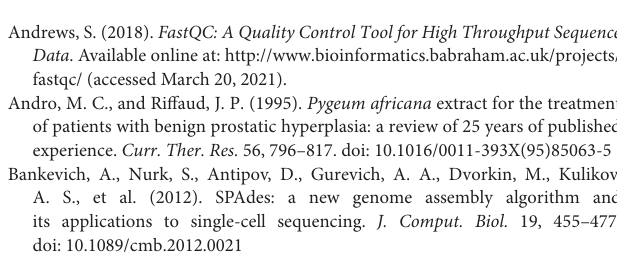
Supplementary Figure 1 | Structural variation between plastomes of Maddenia and outgroups revealed by Mauve. Supplementary Figure 2 | Comparison of the large-single-copy (LSC), inverted repeats (IRs), and small-single-copy (SSC) border regions of Maddenia plastomes. Supplementary Figure 3 | Microsatellites number of different base compositions and distribution of all repeated sequences. (A) Frequency of microsatellites by base composition; (B) Number of all repeats by location. CDS, coding sequences; IGS, intergenic spacers. Supplementary Figure 4 | Phylogenetic relationships of Maddenia inferred from Bayesian inference (BI) and maximum likelihood (ML) based on six datasets. (A) complete plastomes; (B) coding regions; (C) LSC region; (D) non-coding regions; (E) SSC region; (F) IR region. The support values above the branches show PP (posterior probability) / BS (bootstrap support), and asterisks indicate 1.00/100%. Dashes represent incongruences of BI and ML trees. Supplementary Figure 5 | Maximum likelihood inferred from 413 single-copy nuclear (SCN) genes of Maddenia group of Prunus . The number above branch indicated bootstrap support from the IQ-TREE. Supplementary Figure 6 | The pseudolikelihood network score from the Species Networks applying Quartets (SNaQ) analysis for each of the maximum number of hybridizations allowed ( h max ). Supplementary Table 1 | Genes present in the 17 complete Maddenia chloroplast